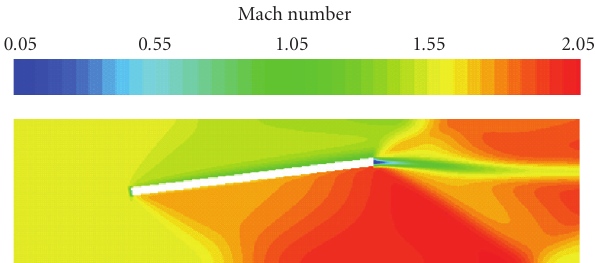
Figure 16: Mach No. distribution (HTPB slab @ AOA = 7 ◦ ).